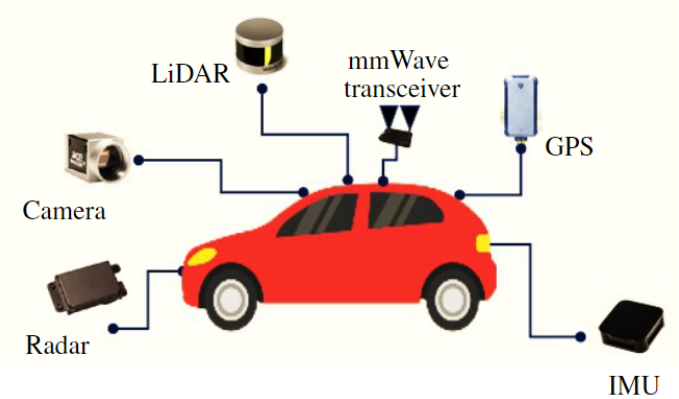
Figure 2. Sensors connected autonomous vehicle with WiFi-based mmWave